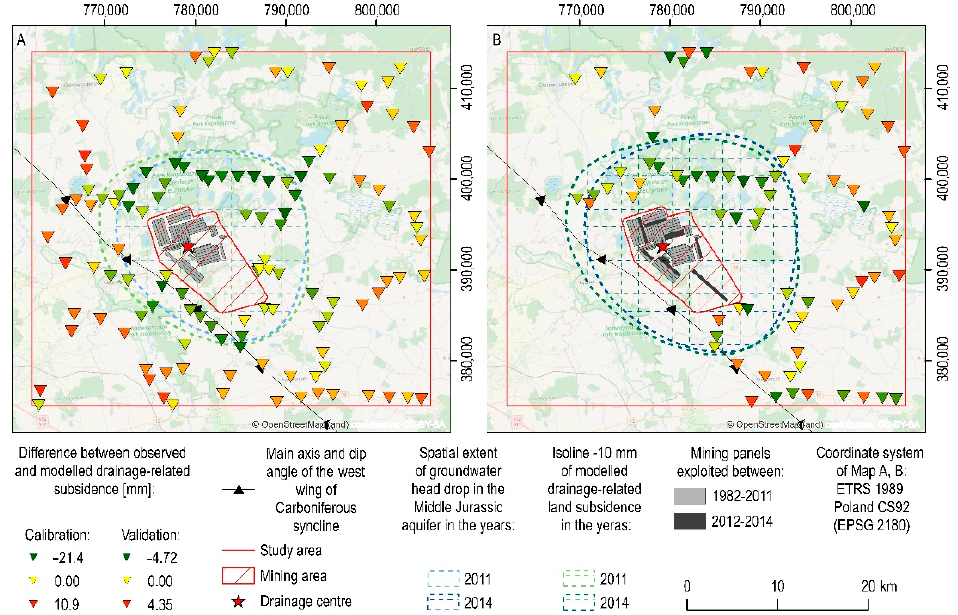
Figure 9. The spatial distribution of model errors for ( A ) calibration and ( B ) validation periods. Due to the asymmetry of the depression cone in the Middle Jurassic aquifer and the averaging properties of the model considering the rock mass conditions, the model has a zone of slight underestimation off drainage-related land subsidence inside the mining area and a zone of slight overestimation of land subsidence in the peripheral areas of the study.